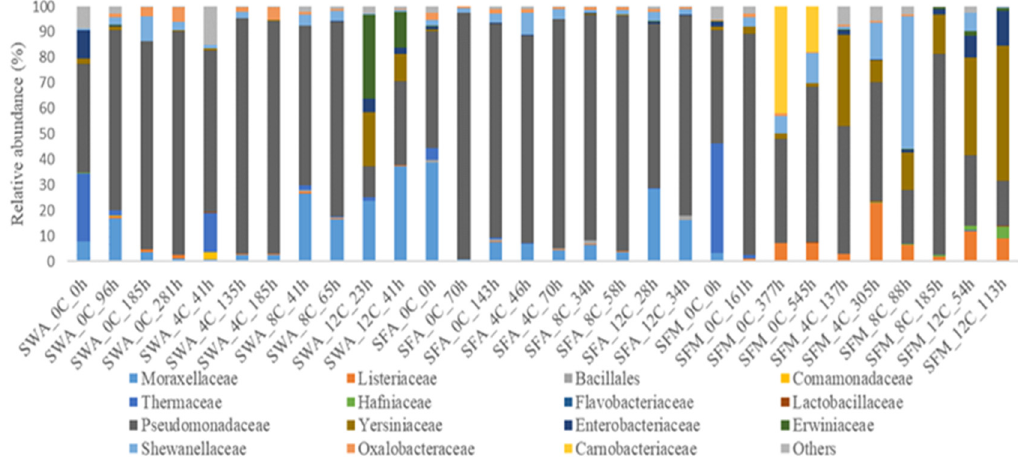
Figure 1. Relative abundance (%) of bacterial families of whole (SW) and filleted sea bass (SF) at intervals of storage hours (h), at various temperatures (C) under air (A) and MAP (M) conditions, as revealed by 16S rRNA metabarcoding analysis.